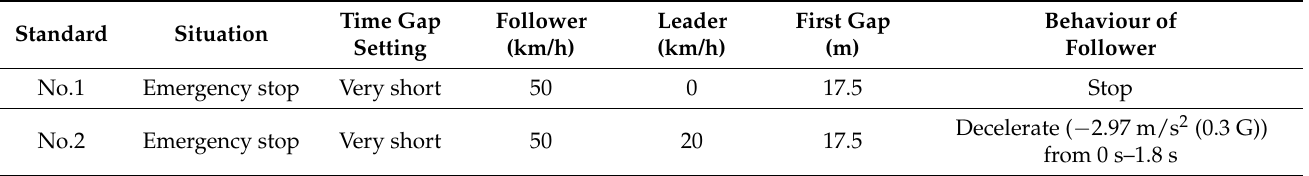
Table 4. Validation of collision avoidance system.